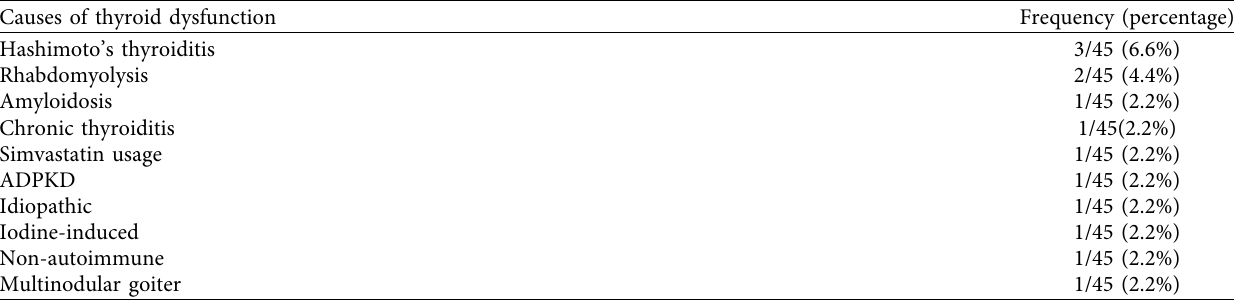
Table 2: Causes of thyroid dysfunction in kidney failure.